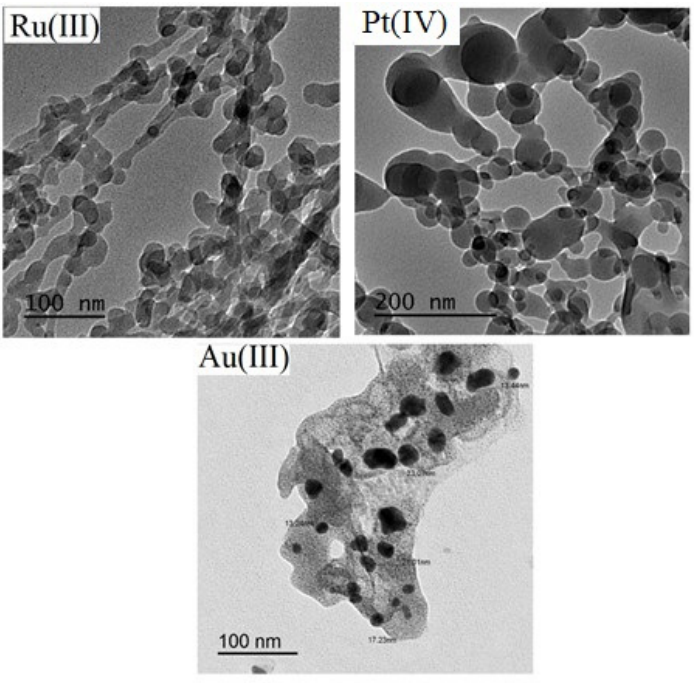
Figure 5. TEM images of Au (III) Pt (IV), and Ru(III), complexes. Table 7. Results of antibacterial activity of the prepared complexes.